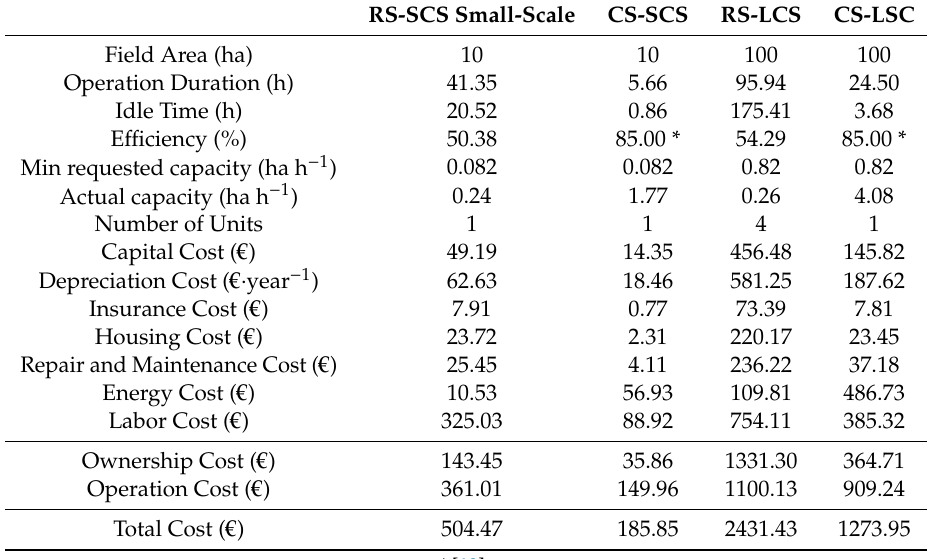
Table 2. Calculated parameters and costs (RS—Robotic System; CS—Conventional System; SCS—small-scale scenario; LSS—Large-scale